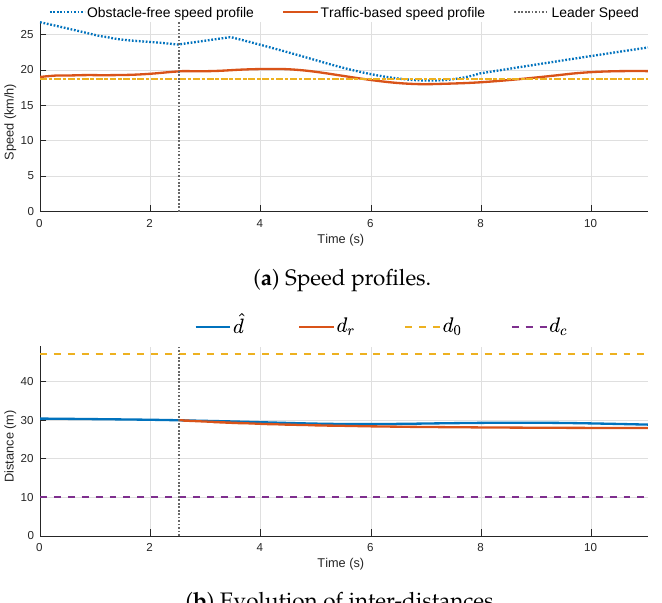
( b ) Evolution of inter-distances. Figure 8. Speed profile generation for the best trajectory candidate in the roundabout traffic